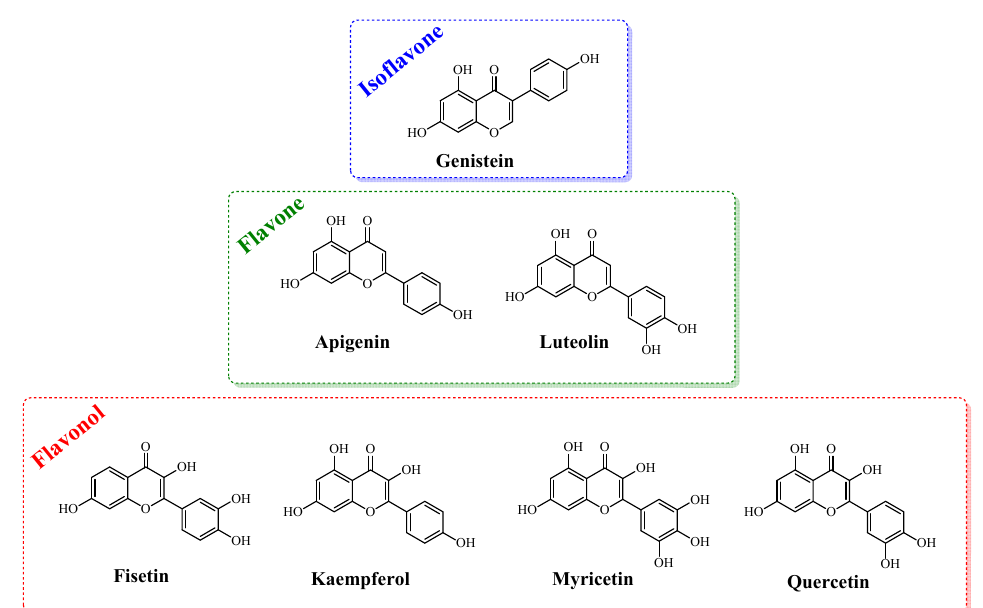
Figure 1. The chemical structures of the flavonoids evaluated in this work.